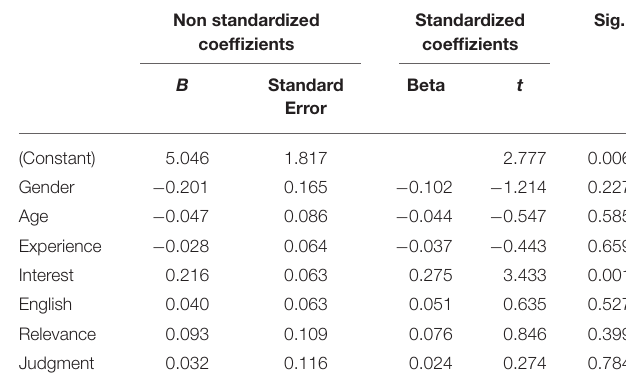
TABLE 3 | Linear regression model predicting the score on the UN-scale in the Chinese